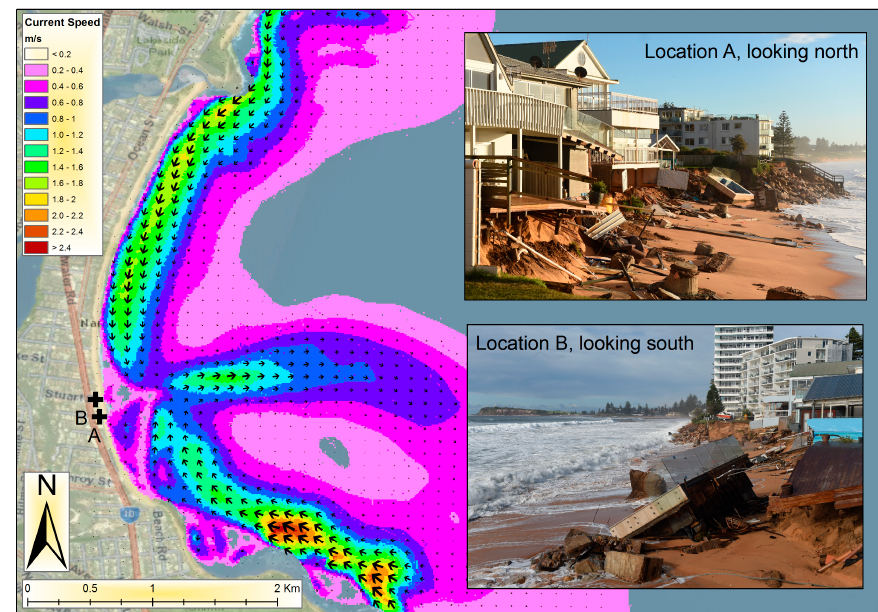
Figure 11. Modelled nearshore current pattern (m/s) at Narrabeen–Collaroy during the peak of the June 2016 storm (as shown in Figure 10B), and locations of observed severe erosion damage at Collaroy. Area of most extreme erosion corresponds to the location of the modelled storm rip current. Source of images Australian Associated Press (rights for reproduction purchased) [39].